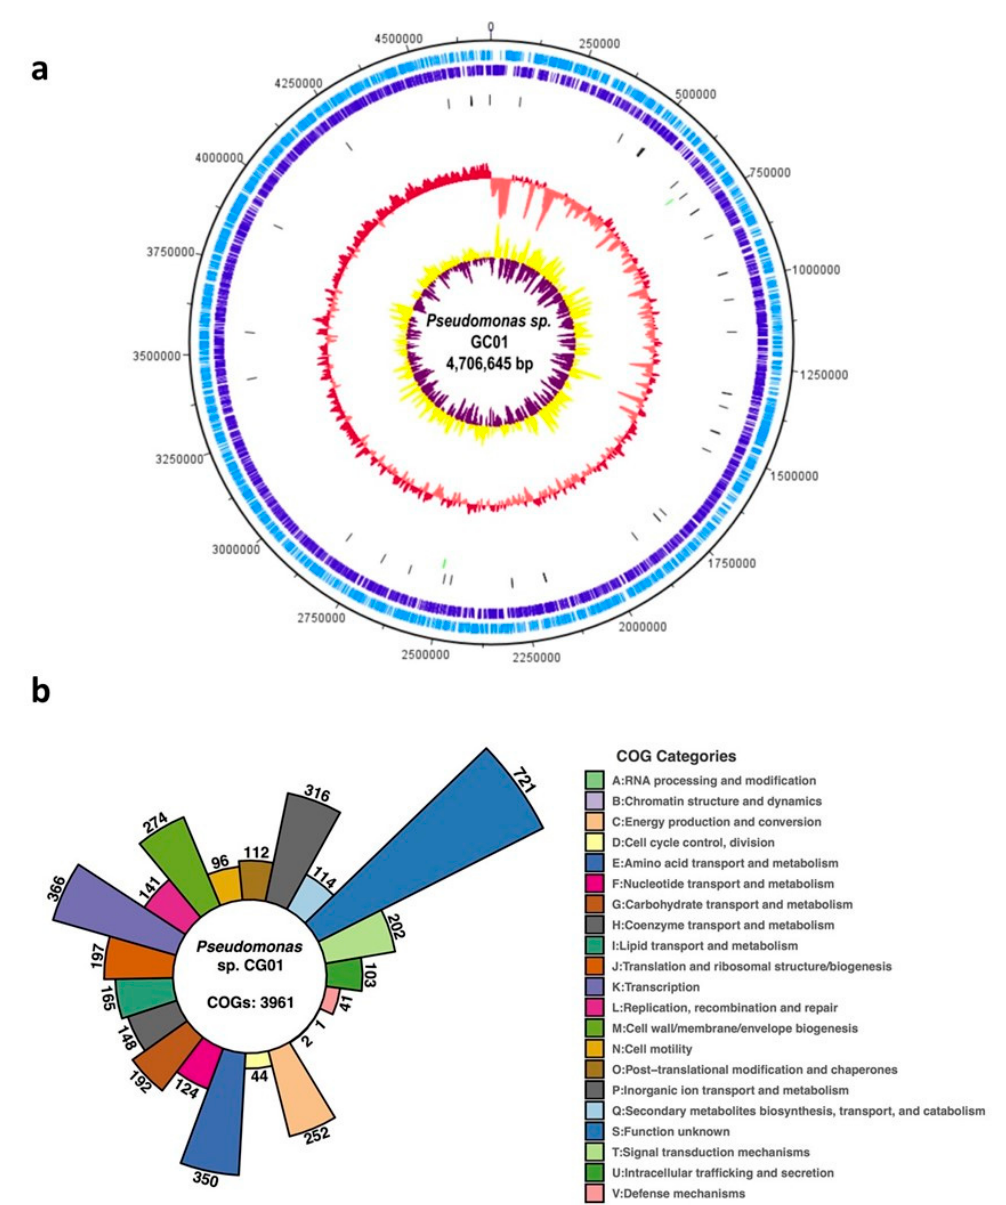
Figure 1. Genome characteristics of Pseudomonas sp. GC01. ( a ) Complete chromosome map of Pseudomonas sp. GC01. The chromosome map comprises six circles. The dark-blue and light-blue circles show the positions of the protein-coding genes on the plus and minus strands. The black bars on the third circle represent tRNA genes. The green bars on the fourth circle represent rRNA genes. The pink/red circle shows the GC content. The purple/yellow circle shows the GC skew. ( b ) Distribution of COG categories on the Pseudomonas sp. GC01 predicted proteins. The figure shows the number of CDSs assigned in each COG category depicted by color.